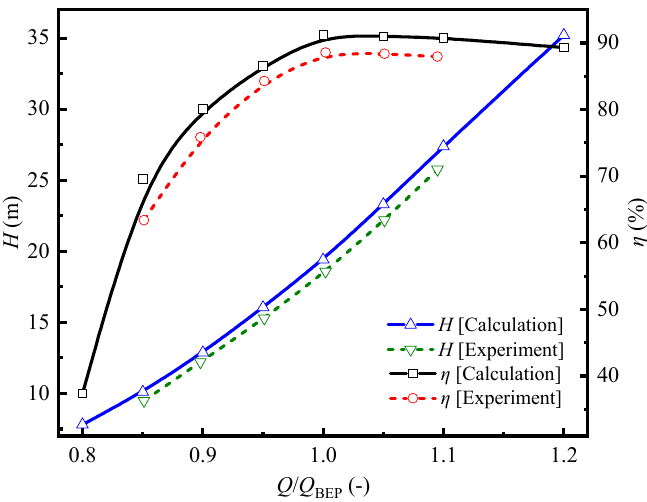
Figure 7. Comparison of the experimental and numerical simulation results.